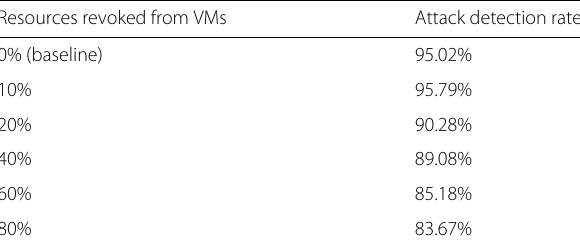
Table 1 Attack detection rates when revoking resources (CPU, Memory, I/O and Network) from VMs Resources revoked from VMs